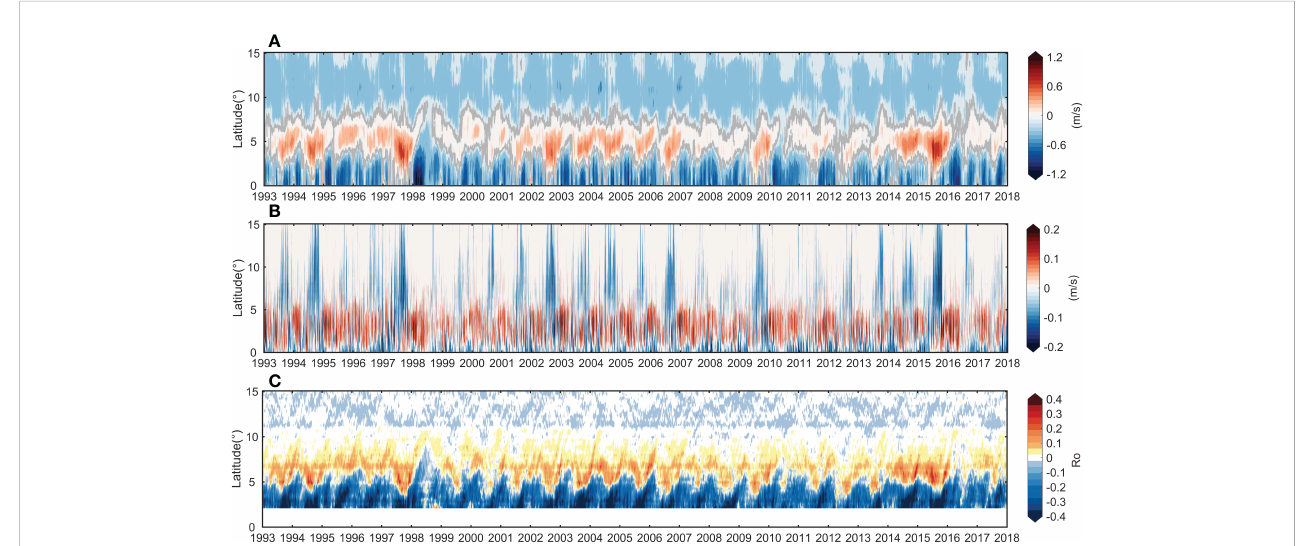
FIGURE 6 Time series of the zonal-averaged (A) U and (B) V components of the background current velocity, and (C) Rossby number ( Ro ) for the 1993 – 2017 period. The gray lines in (A) show the contour of zero value. The U/V-velocity in this plot is derived from the variables of CMEMS data.